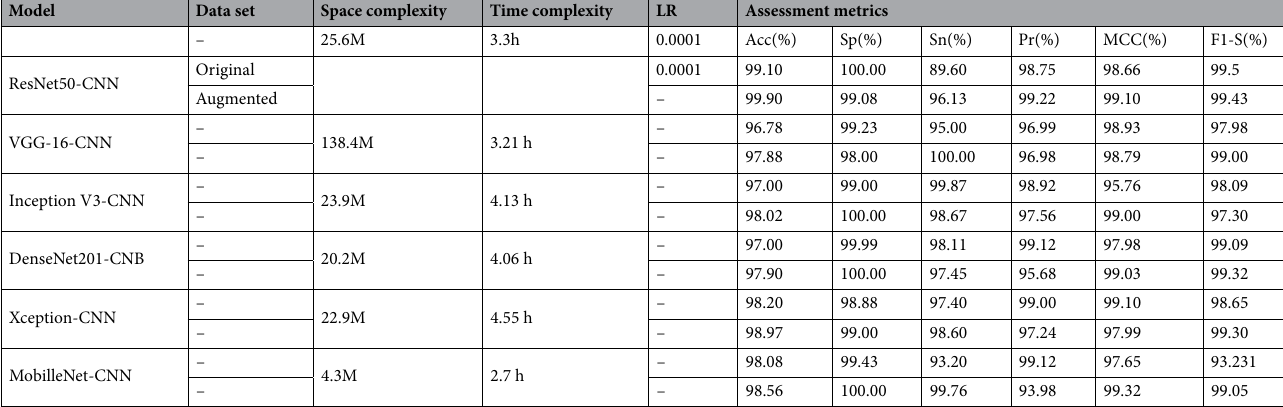
Table 4. Integrated frameworks (ResNet-50-CNN, VGG-16-CNN, Inception V3-CNN, DenseNet201- CNN, Xception-CNN, and MobilleNet-CNN) performance on original and augmented data sets. The space complexity of each model is the number of trainable parameters. M = Million. The space complexity increases with increasing number of trainable parameters. The time complexity is the training time (in hours) of the models.